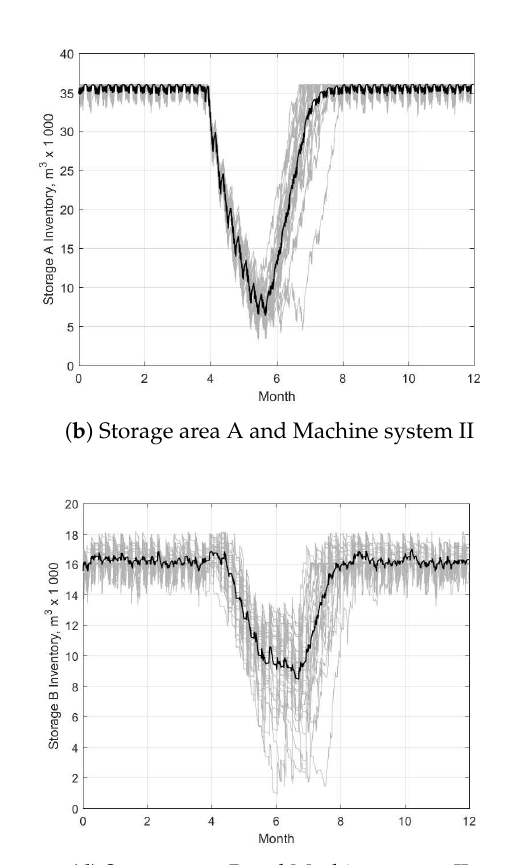
Figure 4. Average of 30 yearly simulation results (black line) and individual results of 30 yearly simulations (grey lines) showing inventory level fluctuation at storage areas A, B, C, and D under Strategy I using Machine Systems I (left side) and II (right side) (S1 M1 and M2).